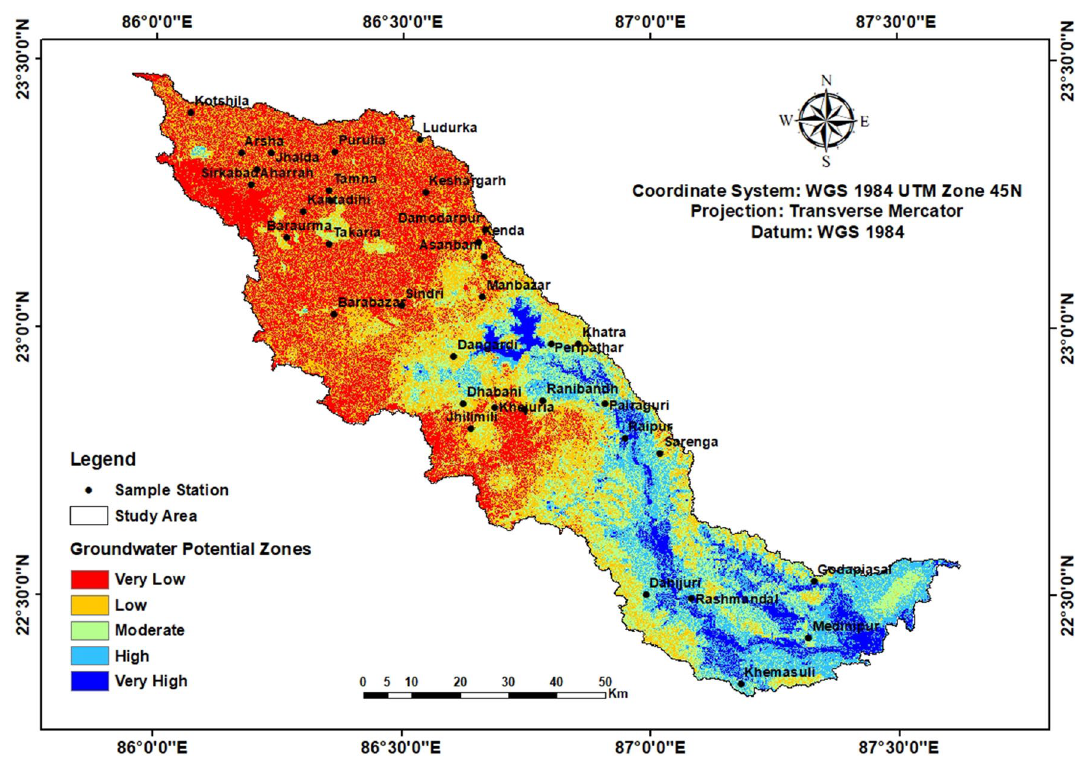
Fig. 14 Map showing the spatial distribution of groundwater potential zones in Kangsabati River